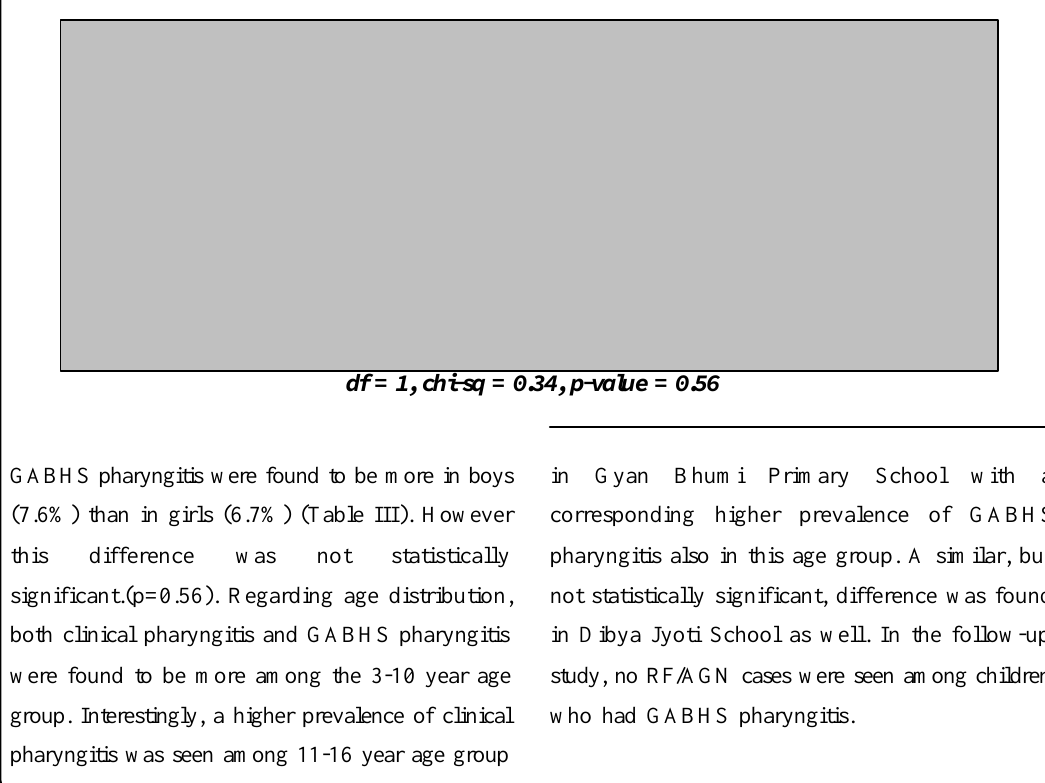
Table III: Sex distribution of clinical and GABHS Pharyngtis in 6